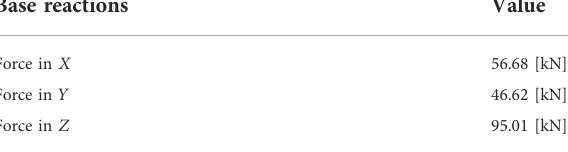
TABLE 6 Maximum forces presented due to the action of the seismic load at the base. Base reactions